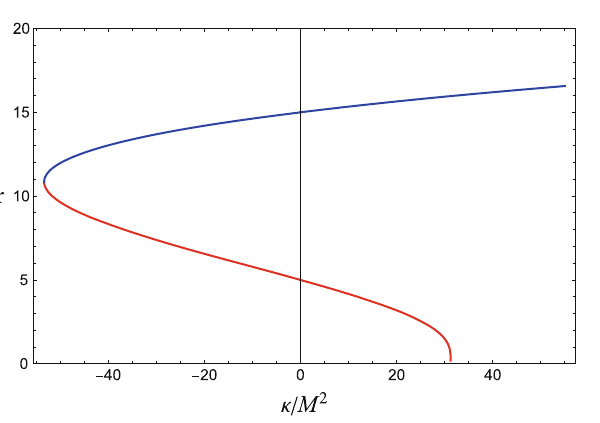
join together. Finite V ef f at the origin occurs when the red line reaches r = 0. On the other hand, V ef f → +∞ happens at the area of κ/ M 2 where there is no existing red